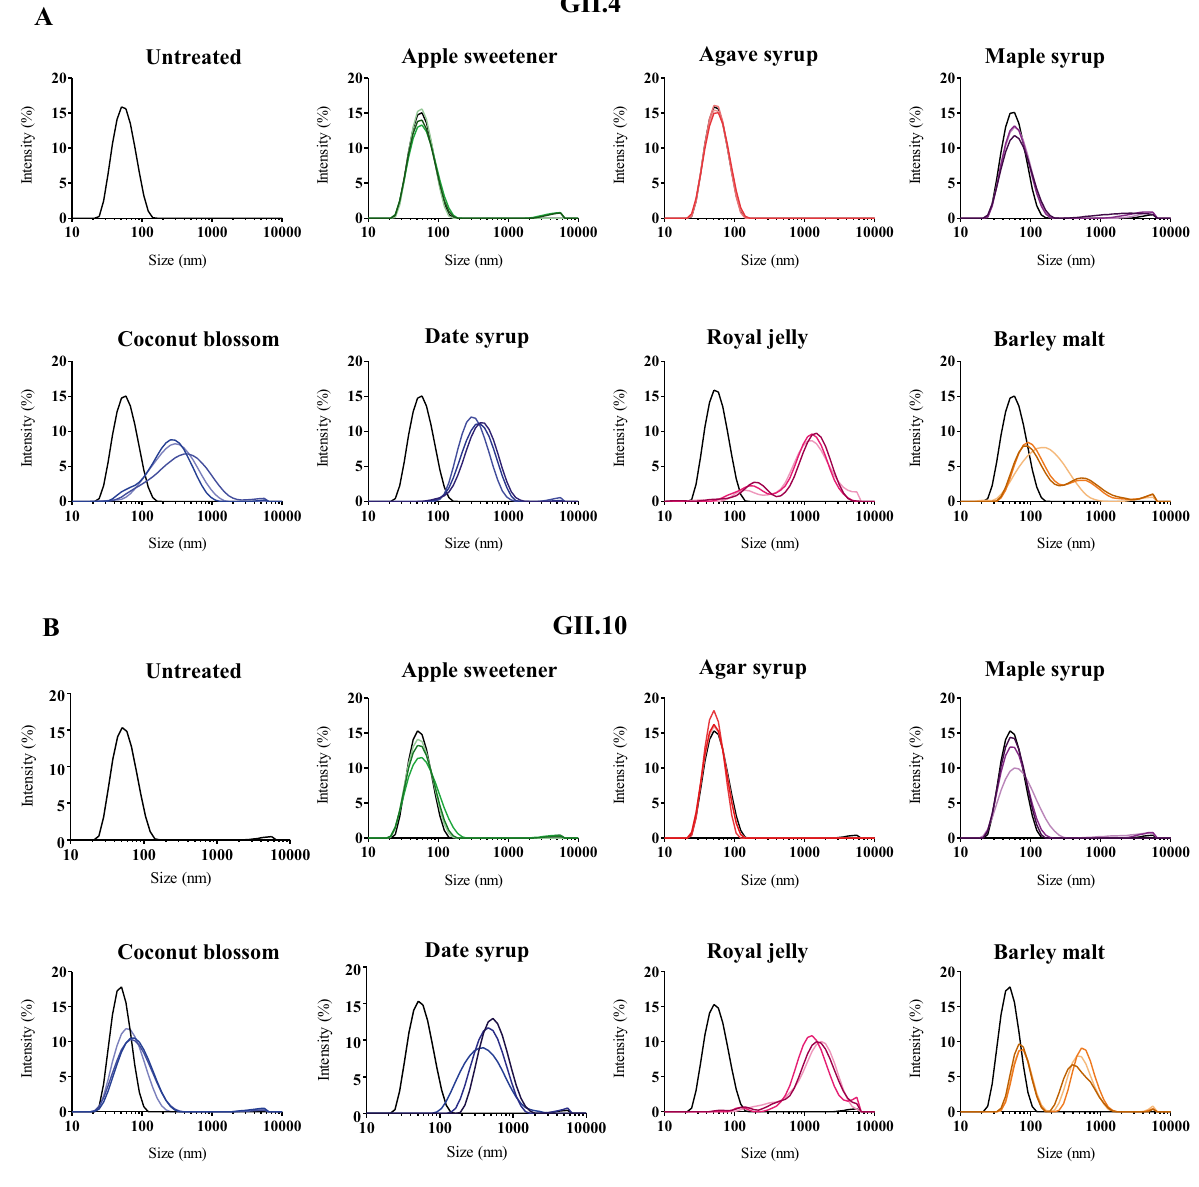
Figure 2. Natural extracts and DLS measurements of GII.4 and GII.10 VLPs. DLS was used to evaluate the hydrodynamic size of the VLPs (measured in intensity) after natural extract treatment (final concentration of extracts 12.5%) at 10 min, 60 min, and 120 min (represented by light, medium, dark colored lines, respectively). Untreated VLPs (black line) showed a single peak at all time points. ( A ) For GII.4, treatment with apple sweetener, agave syrup, and maple syrup there was little effect on the diameters. For coconut blossom syrup and date syrup GII.4 VLPs diameters were larger than the untreated VLPs. For royal jelly and barley malt two new GII.4 VLP peaks with increased diameters were detected. ( B ) For GII.10, apple sweetener and agave syrup treatment of VLPs did not result in increased diameters. Date syrup, coconut blossom syrup, and royal jelly increased the GII.10 VLP diameters, whereas for barley malt two peaks representing increased VLP diameters were observed. Each experiment was performed in triplicate and representative measurements were